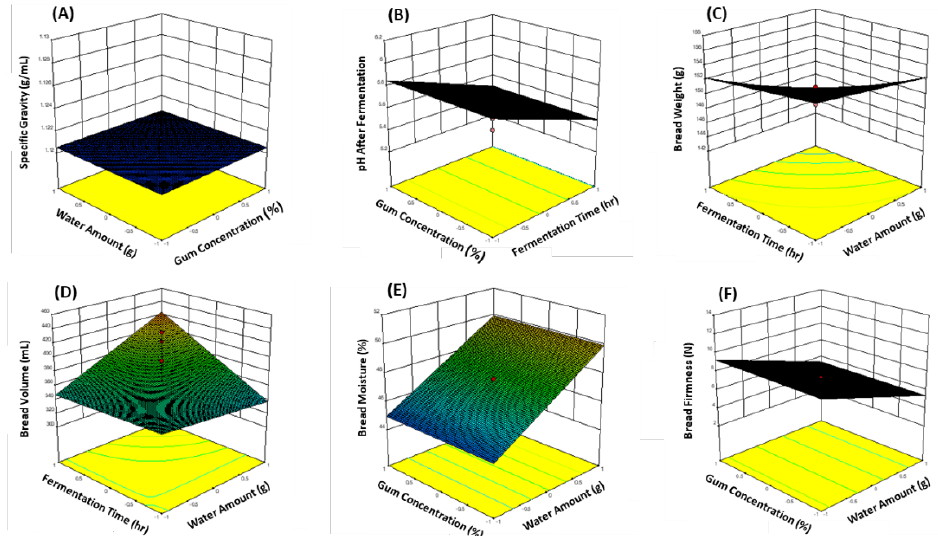
Figure 3. Three-dimensional plots on the characteristics of batter ( A , B ) and bread ( C – F ) affected by significant factors of the formula and processing conditions in the preparation of gluten-free rice bread with tamarind gum.